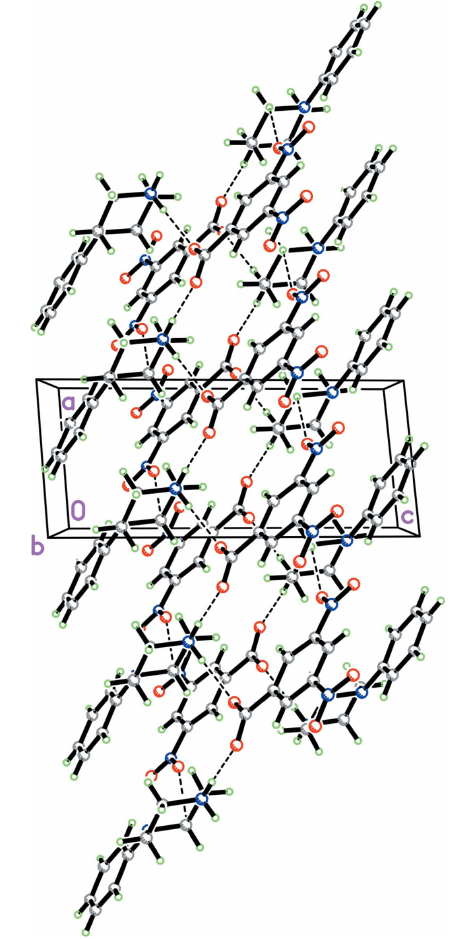
(16) loops linking the phenyl- 4